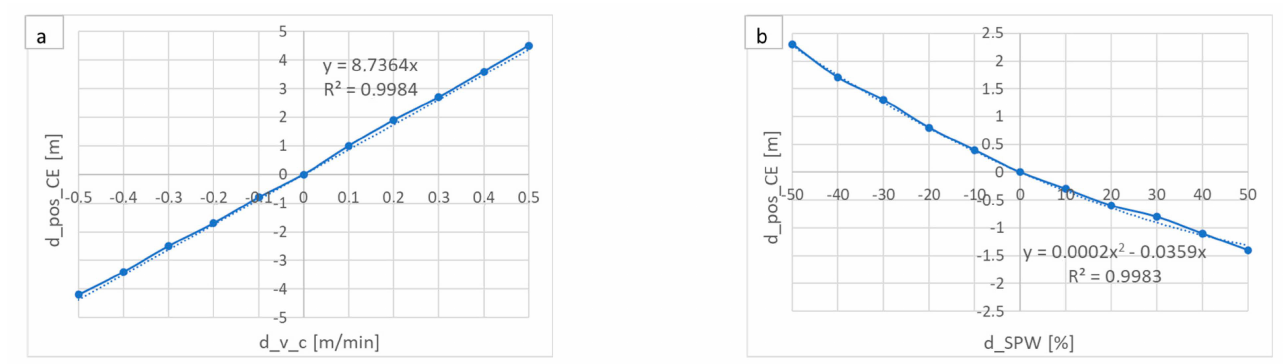
Figure 15. Variation of crater end positions with ( a ) altered casting speed and ( b ) altered spray water flows (with respect to defined reference case) as simulated within offline parameter